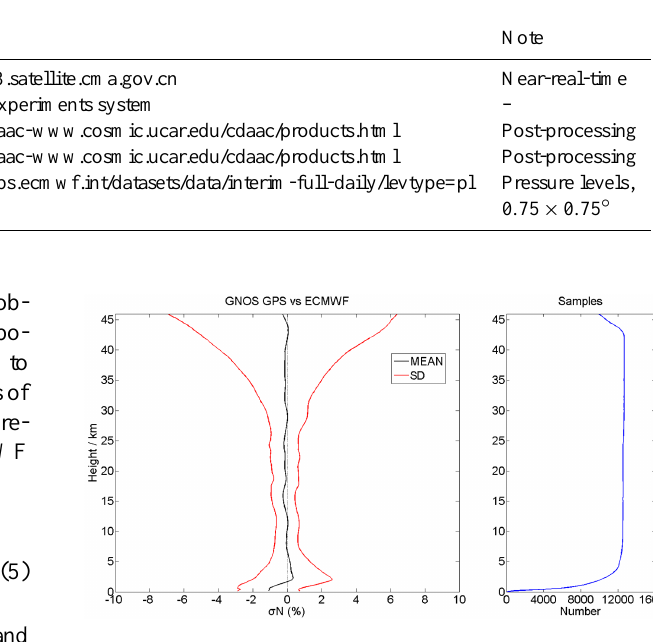
Figure 4. Refractivity deviation from the ECMWF reanalysis for GNOS GPS (from 1 November to 31 December 2013). The left panel shows the mean bias (black) and the standard deviation (red), and the right panel shows the samples used vs.